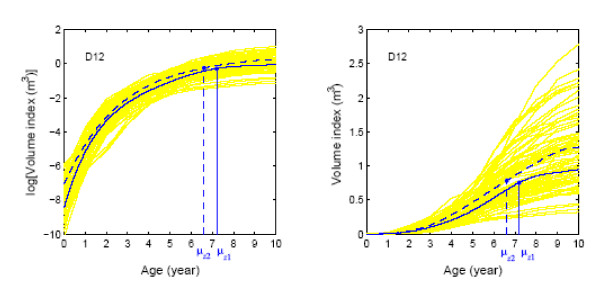
Volume growth curves for two different QTL genotypes for the QTL detected on linkage group 12 by the Legendre polynomial-based model. See Figure 3 for all the explanations.